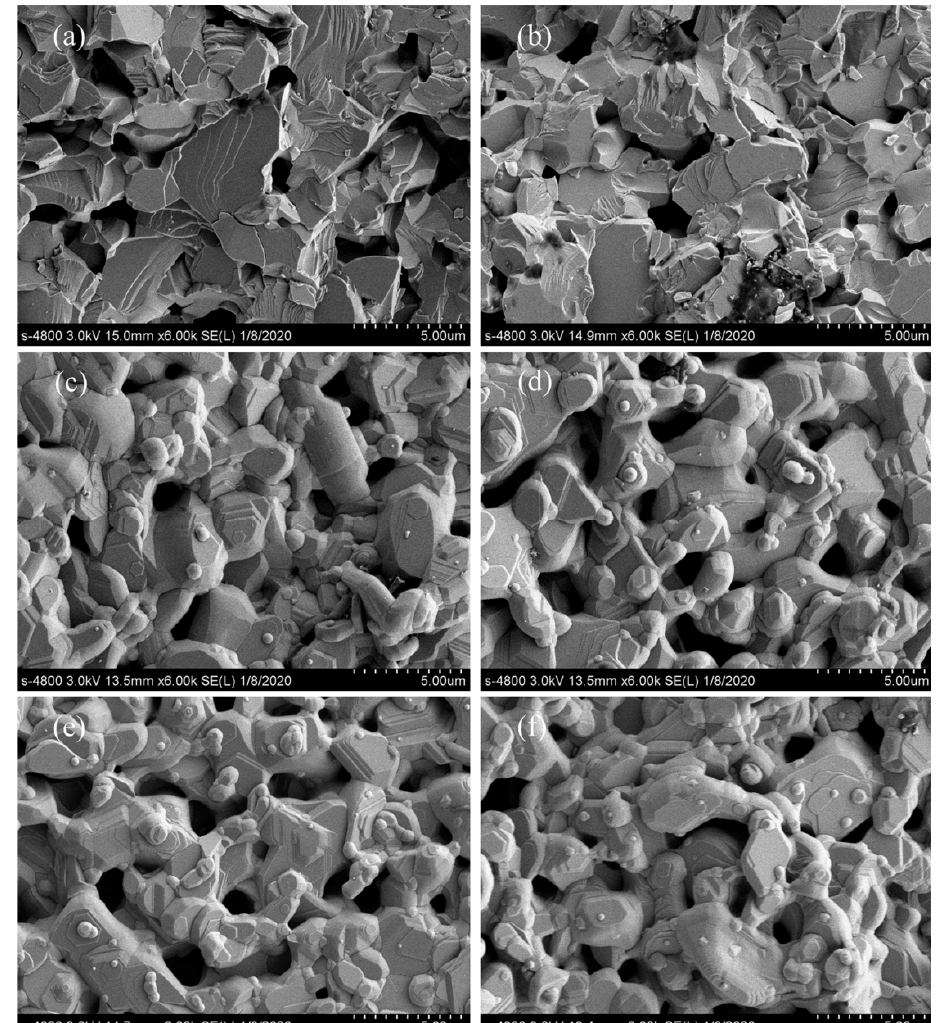
Figure 4. FE-SEM fracture surface of the W-type SrYb hexaferrite Sr 0.85 Yb 0.15 Zn 1.5 Co 0.5 Al x Fe 16 − x O 27 with Al contents (x) of ( a ) x = 0.00 and ( b ) x = 0.25, and FE-SEM images of the W-type SrYb hexaferrite Sr 0.85 Yb 0.15 Zn 1.5 Co 0.5 Al x Fe 16 − x O 27 with Al contents (x) of ( c ) x = 0.50, ( d ) x = 0.75, ( e ) x = 1.00,